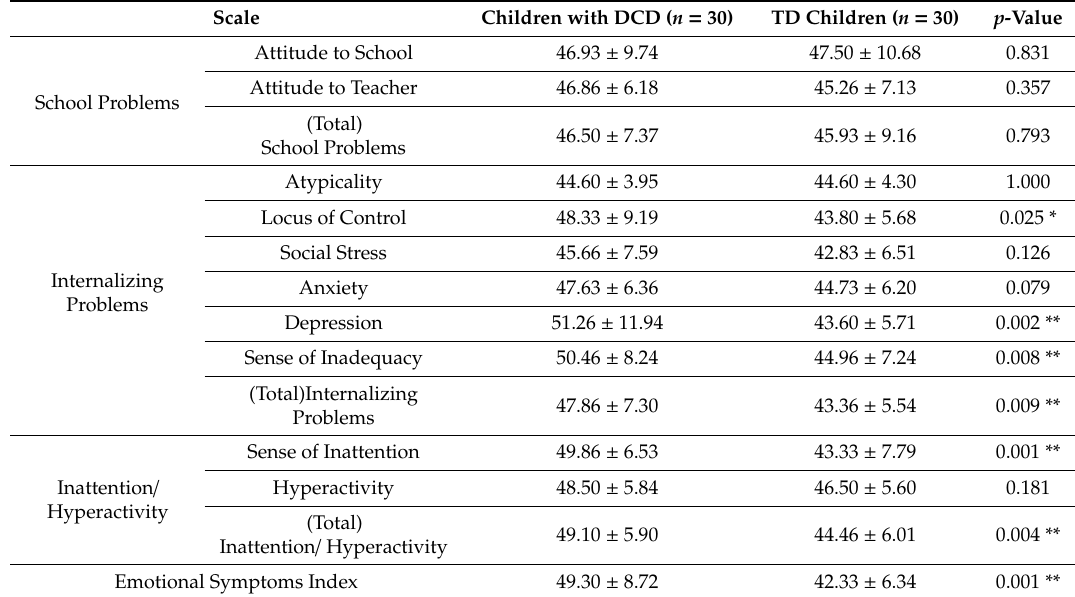
Table 2. Di ff erence between children with developmental coordination disorder (DCD) and typically developing (TD) children’s emotional problems.